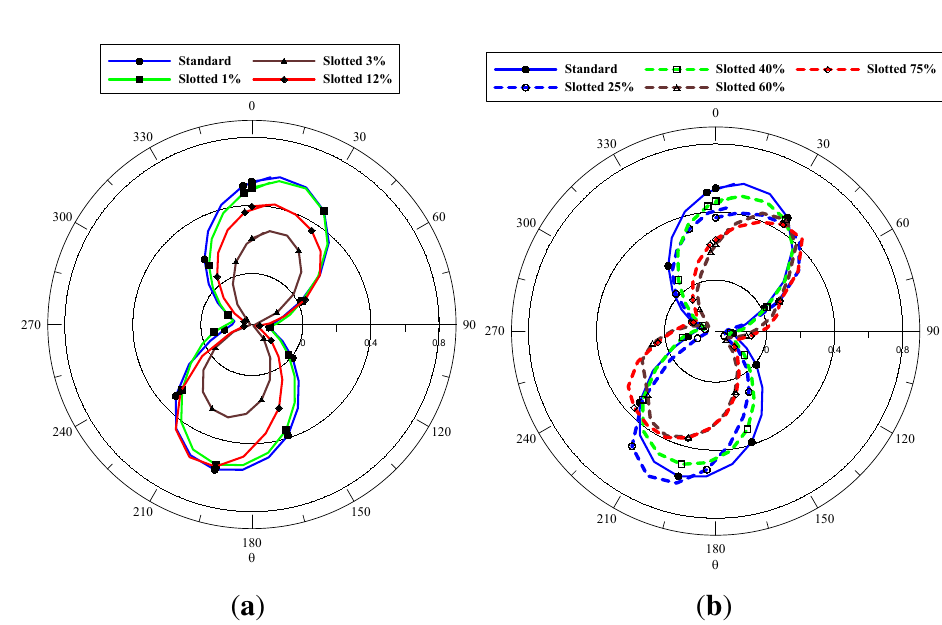
Figure 14. Polar torque coefficient distribution at λ = 1 . 25